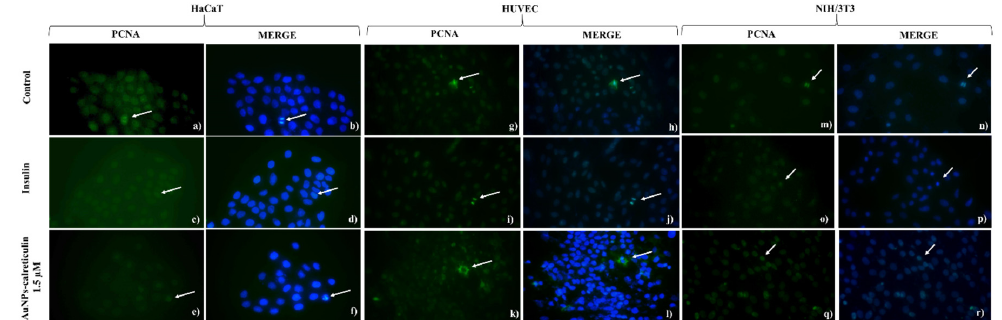
Figure 7. Expression of PCNA by indirect immunofluorescent assay. ( a ) HaCaT cells without treatment, ( b ) 4 ′ ,6-Diamidine-2 ′ -phenylindole dihydrochloride (DAPI), ( c ) cells treated with insulin, ( d ) DAPI, ( e ) cells treated with AuNPs-calreticulin 1.5 µ M, ( f ) DAPI, ( g ) human umbilical vein endothelial cells (HUVEC) cells without treatment, ( h ) DAPI, ( i ) cells treated with insulin, ( j ) DAPI, ( k ) cells treated with AuNPs–calreticulin 1.5 µ M, ( l ) DAPI, ( m ) NIH/3T3 cells without treatment, ( n ) DAPI, ( o ) cells treated with insulin, ( p ) DAPI, ( q ) cells treated with AuNPs-calreticulin 1.5 µ M, and ( r ) DAPI. Expression of PCNA (green) and DAPI (blue) pictures magnification 40 × .